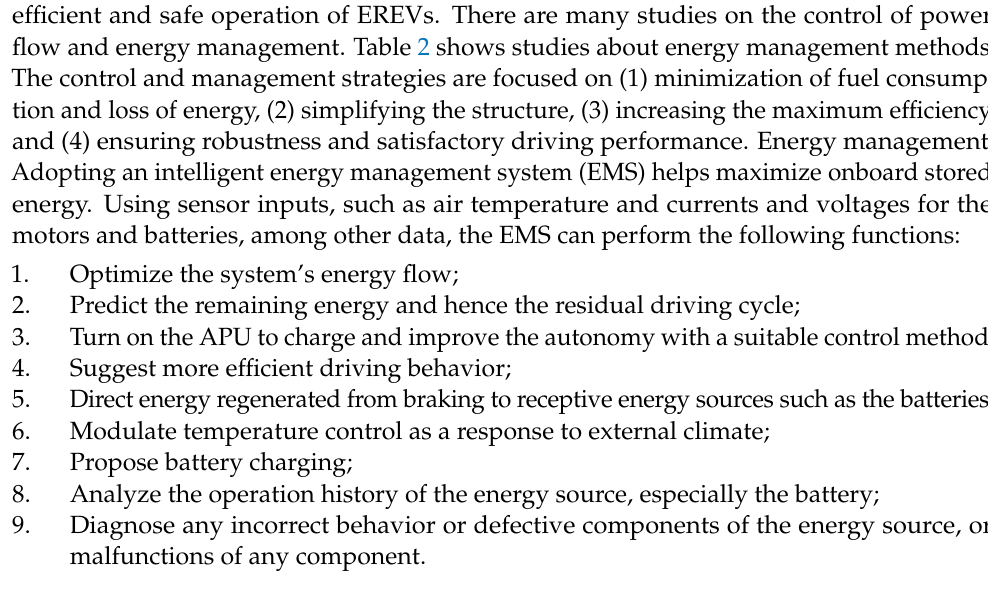
Table 2. A summary of control methods and strategies for